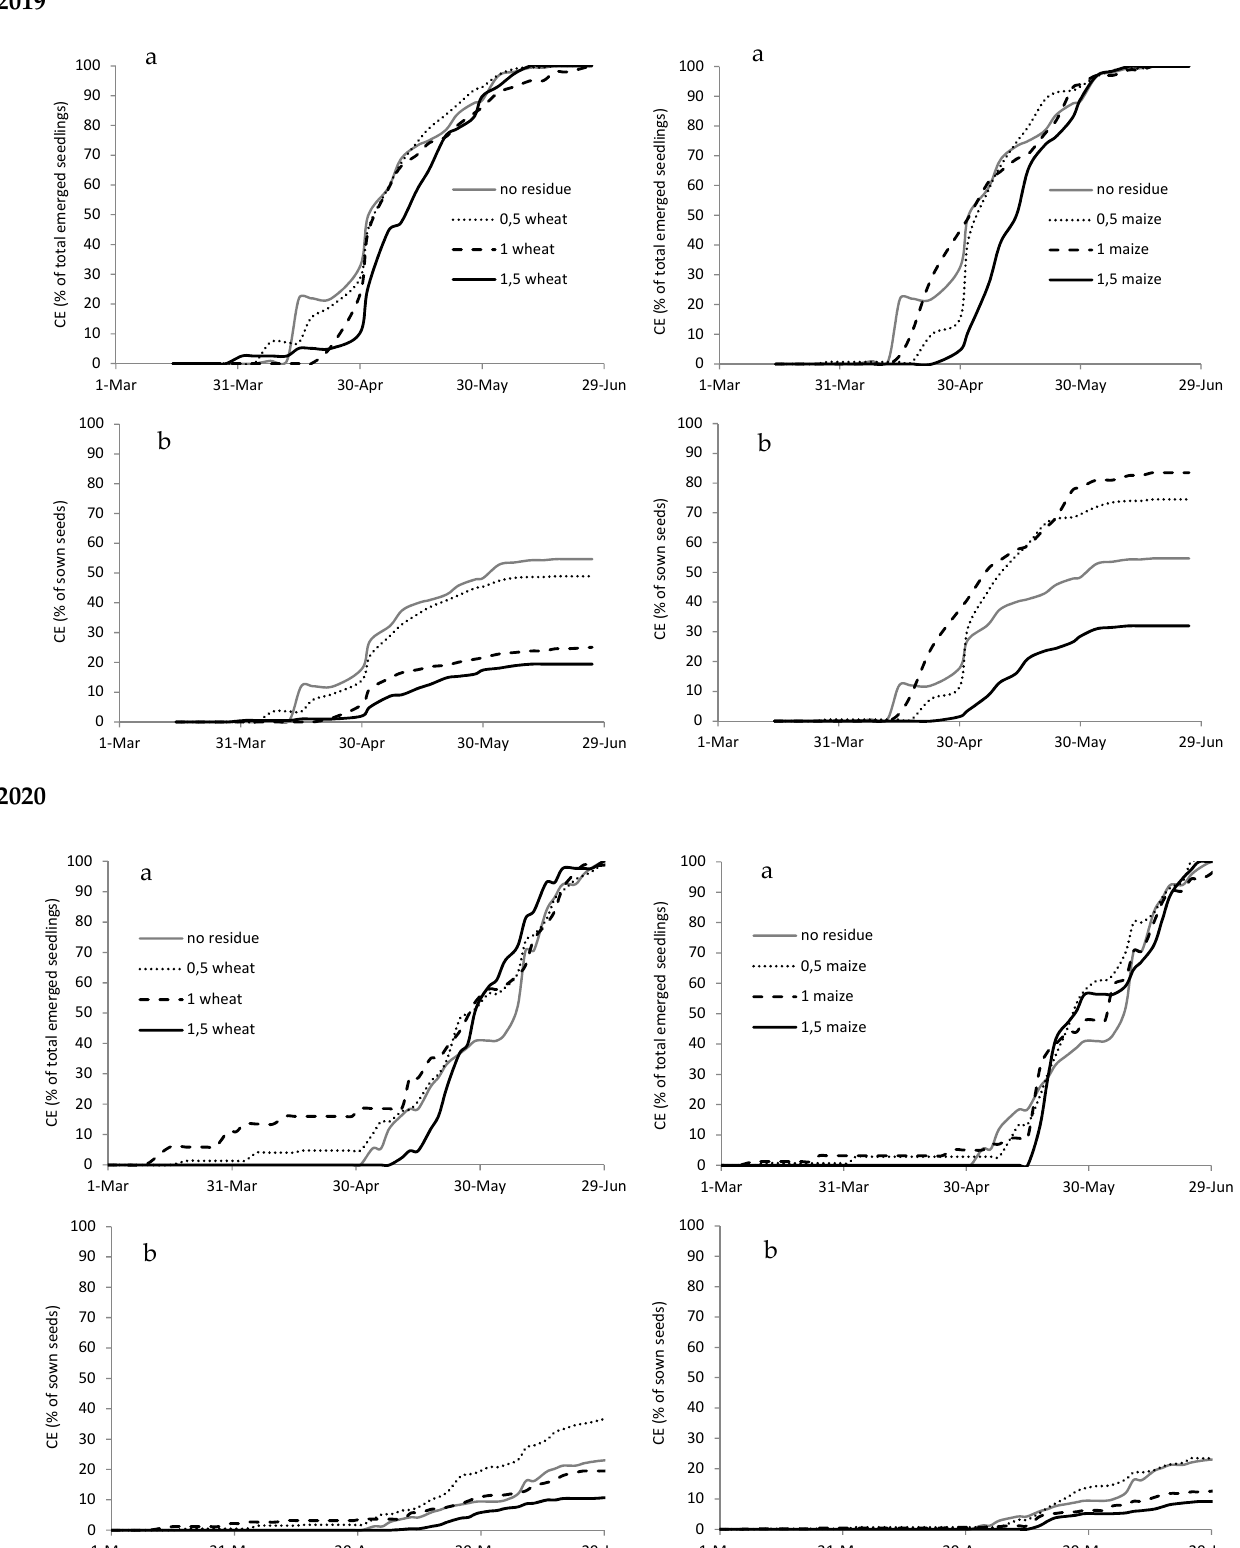
Figure A3. Cumulated emergence (CE) expressed as percentage of total emerged seedlings ( a ) and as percentage of sown seeds ( b ) of Chenopodium album in 2019 and 2020 with different types (wheat on the left and maize on the right) and amounts of crop residues.